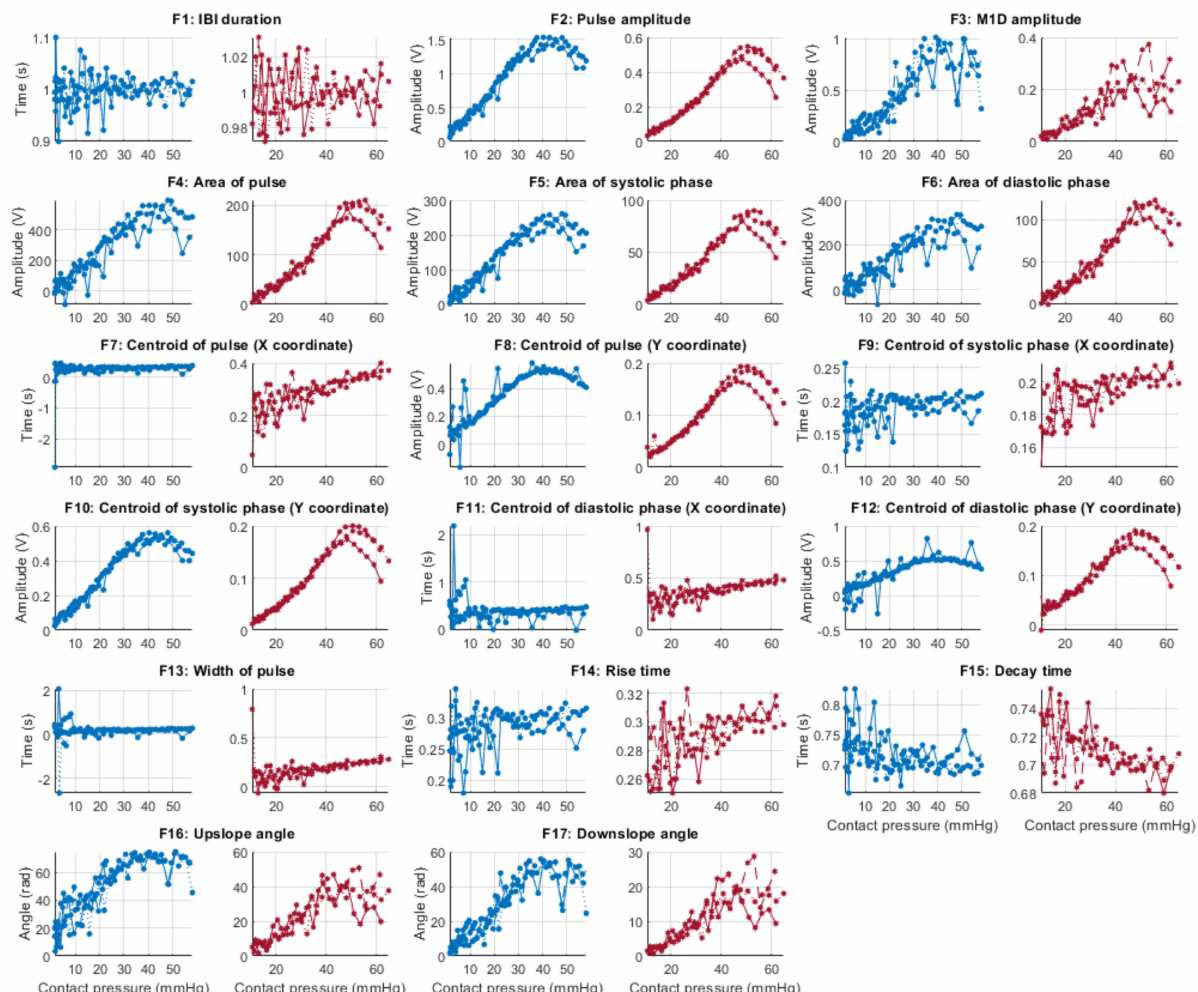
Figure 9. Behaviour of the extracted features during stage 2 hypertension when compared against contact force. Blue lines: Infrared PPG-derived features. Red lines: Red PPG-derived